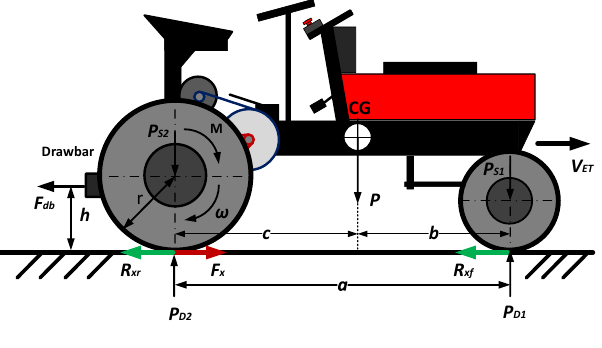
Figure 1. Electric tractor model.